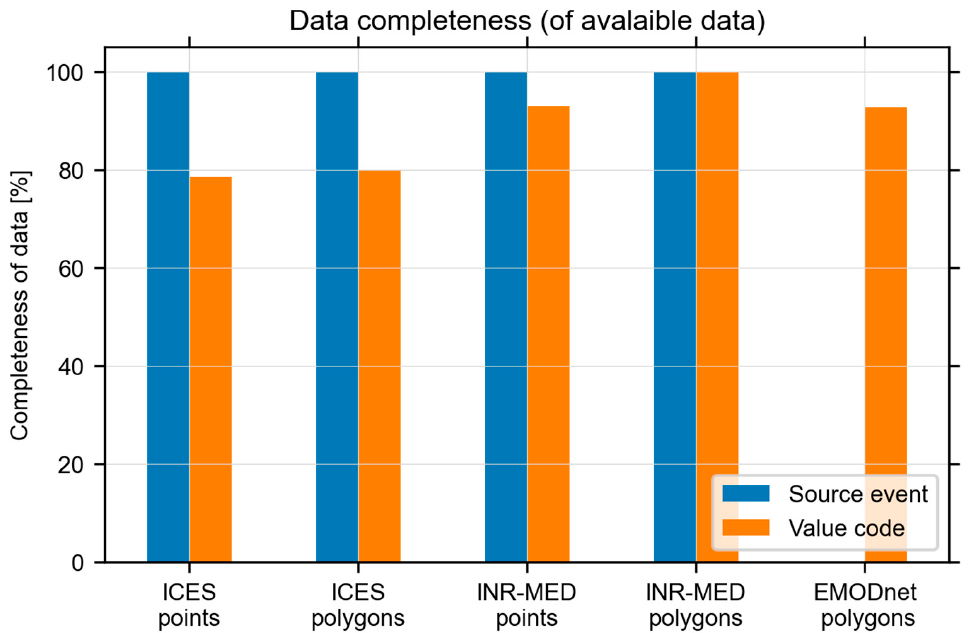
Figure 1. Completeness of available data regarding the parameter source event type (blue) and values code type (orange) as percentage of present/missing entries, provided for the different regional datasets.